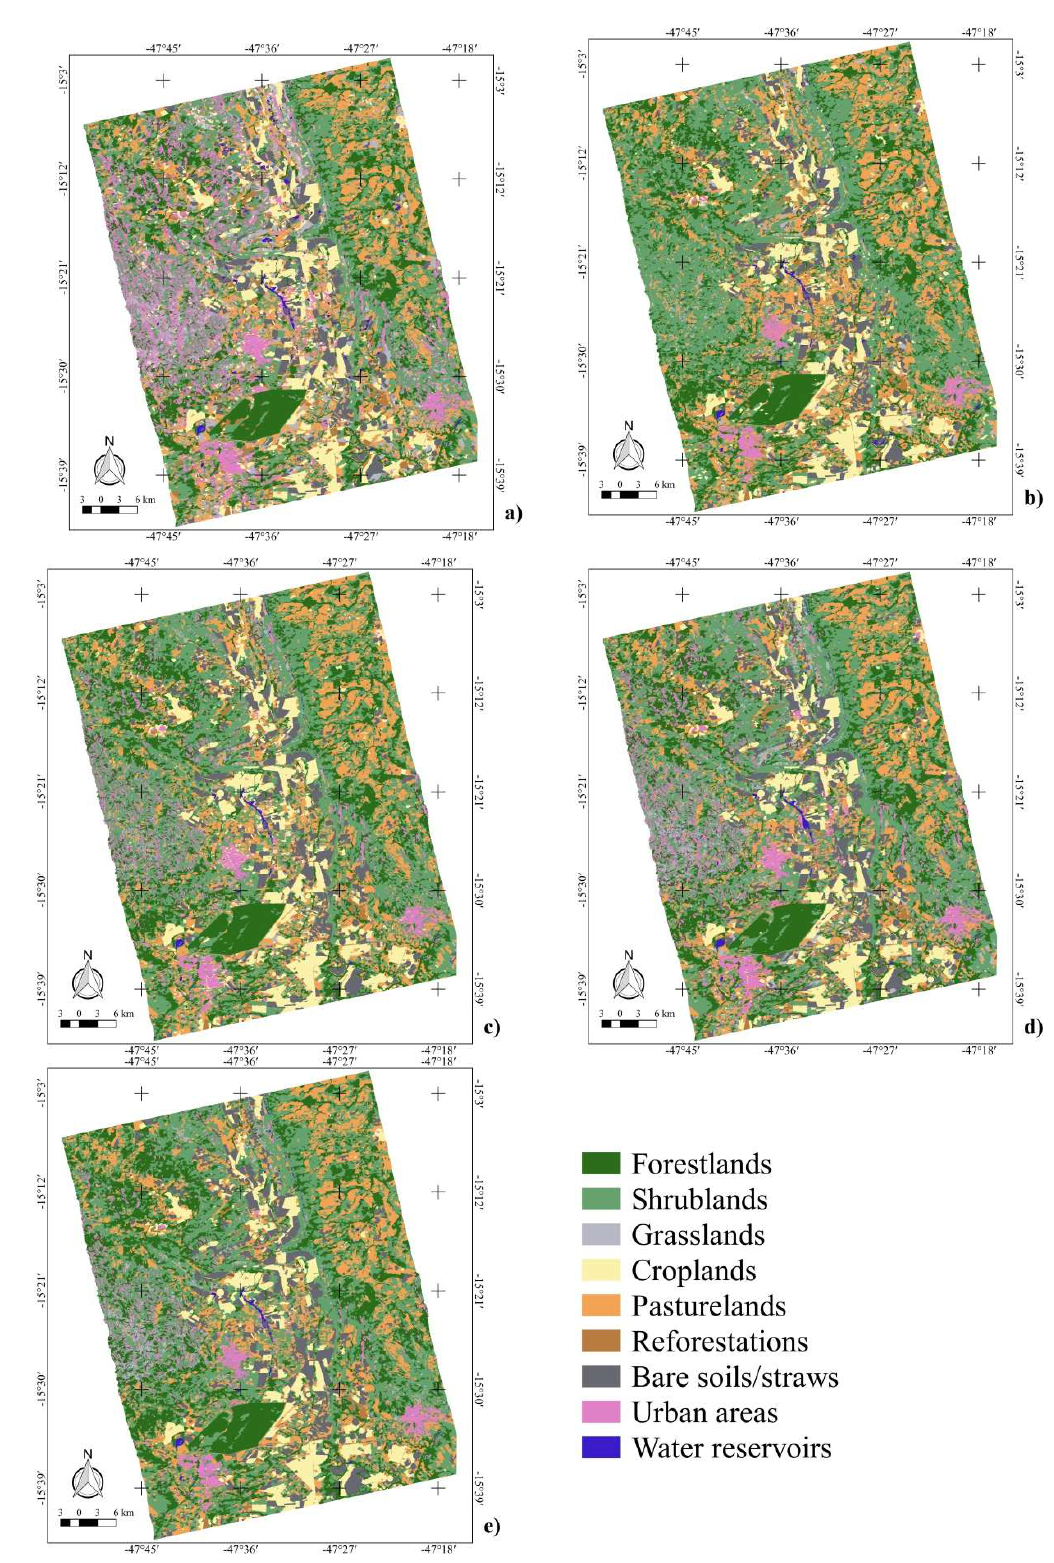
Figure 7. Classification results obtained with NB ( a ), DT J48 ( b ), RF ( c ), MLP ( d ), and SVM ( e ) algorithms and nine land use and land cover (LULC) classes.